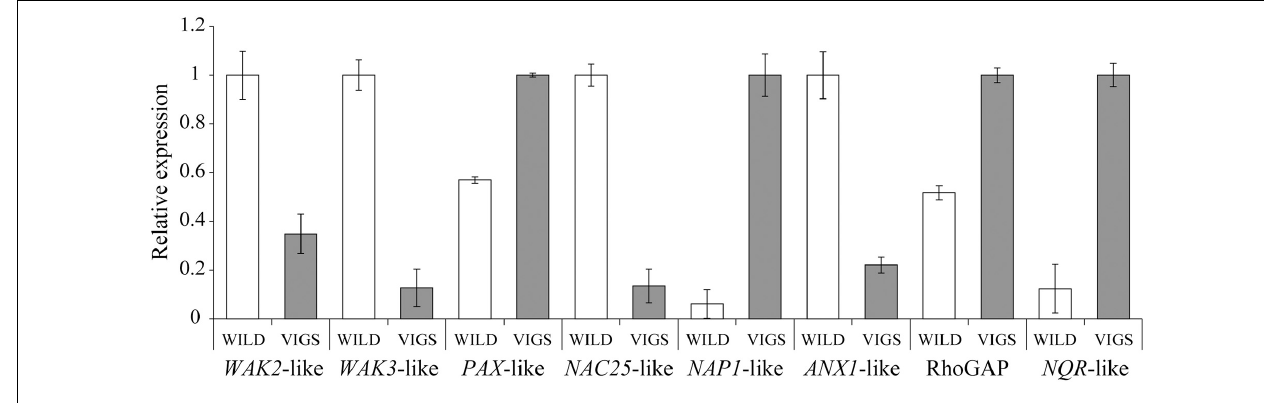
FIGURE 6 | Results of the qRT-PCR analysis to confirm the differential expression of eight DEGs detected through the transcriptome analysis in Eschscholzia californica . WAK2 -like, Eca_sc194563.1_g0010.1; WAK3 -like, Eca_sc000051.1_g1410.1; PAX -like, Eca_sc095603.1_g0010.1; NAC25 -like, Eca_sc194734.1_g0710.1; NAP1 -like, Eca_sc004324.1_g2710.1; ANX1 -like, Eca_sc194691.1_g0370.1; Rho GTPase-activating protein (RhoGAP), Eca_sc009796.1_g0090.1; NADPH:quinone oxidoreductase ( NQR )-like,